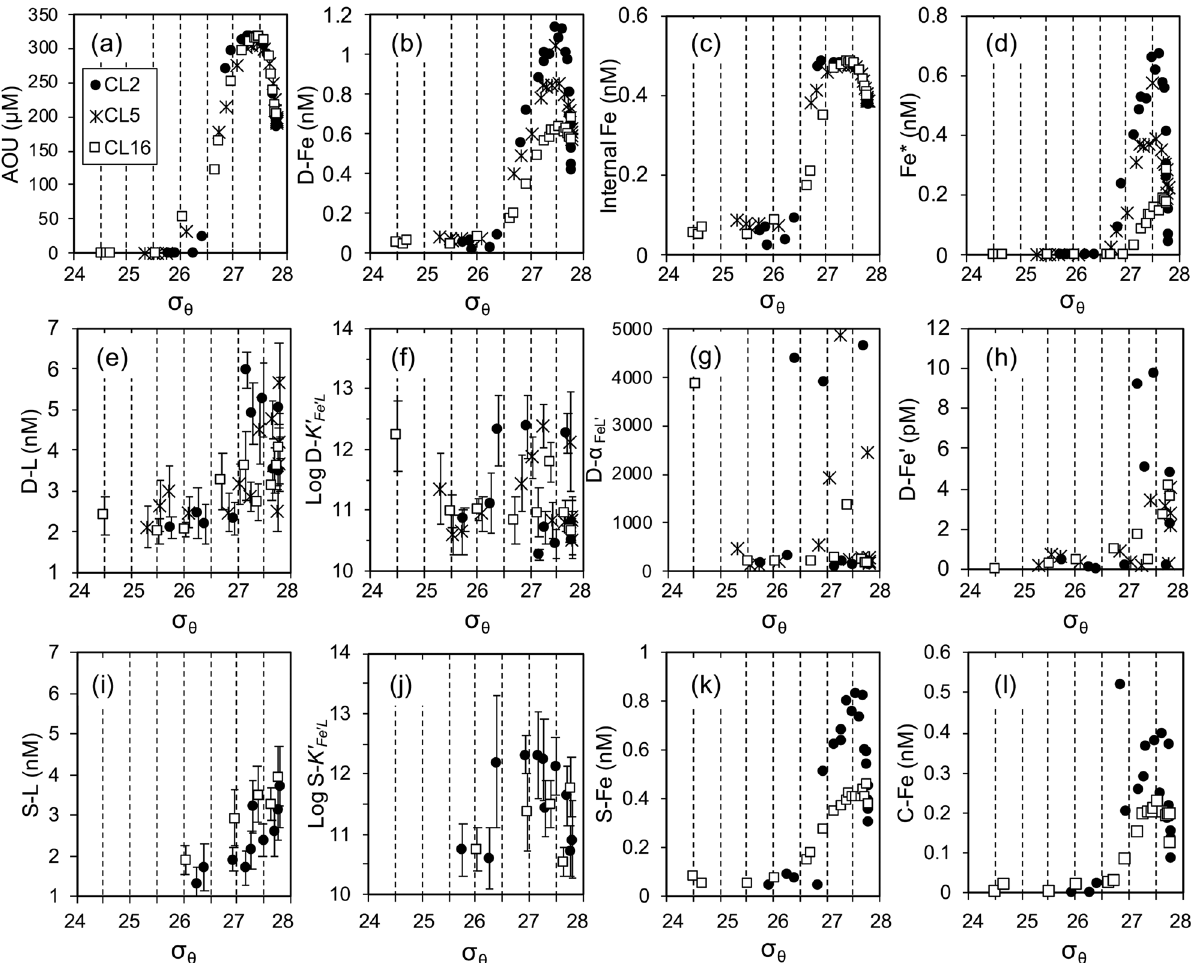
Figure 3. Relationships between σ θ and observed parameters (( a )–( l ), see text) at Stns. CL2 (closed circle), CL5 (asterisk) and CL16 (open square). Error bars in ( e ), ( f ), ( i ) and ( j ) indicate analytical error from ProMCC